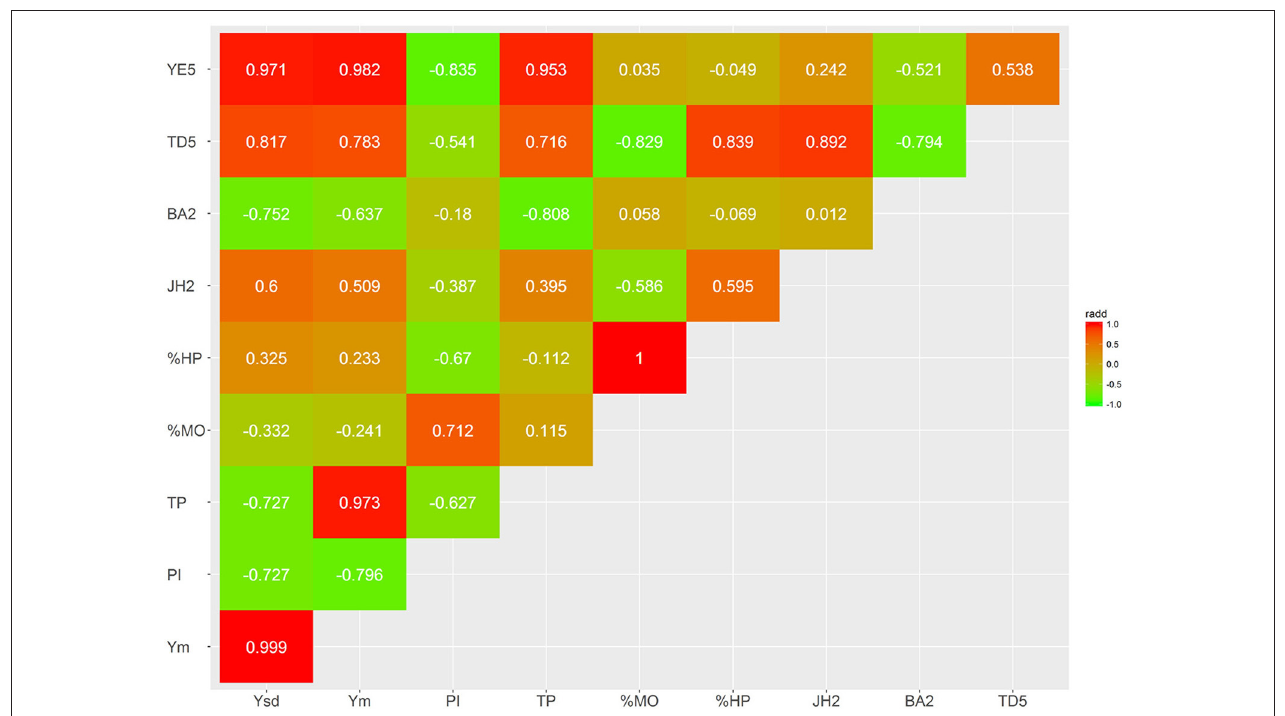
FIGURE 5 | Genetic trait correlations for additive effects: vigor and disease traits.